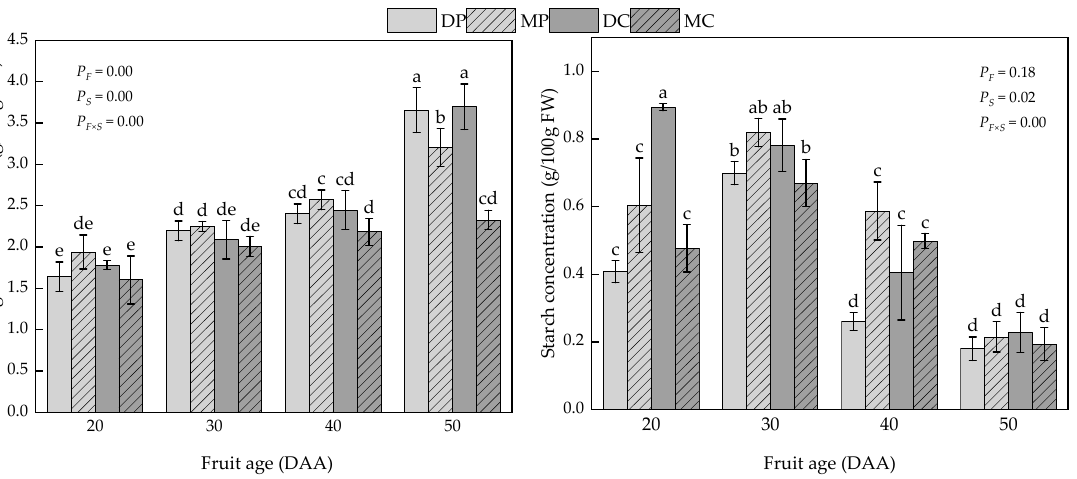
Figure 2. The soluble sugar and starch concentrations of tomato fruits during experimental periods (Different superscripts in each treatment or among treatments indicated significant differences at p < 0.05).